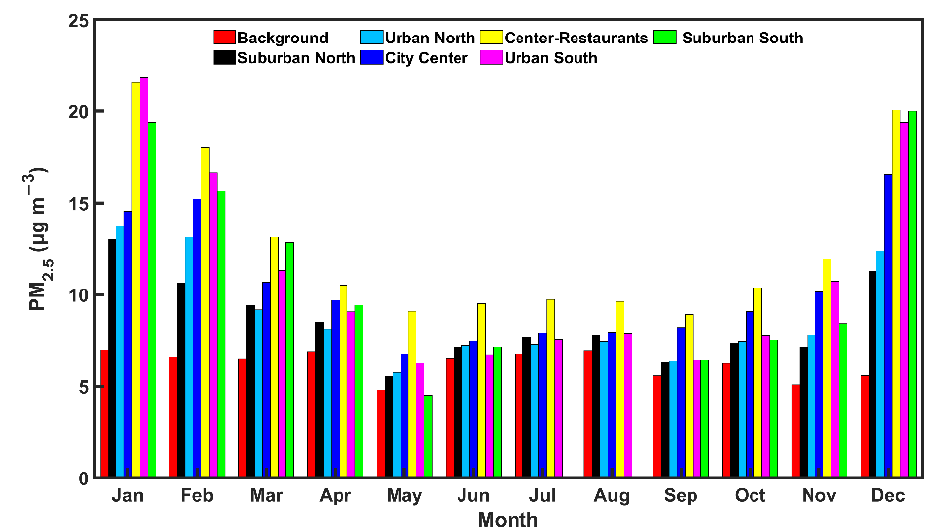
Figure 4. Monthly averaged PM 2.5 concentrations for different areas in the city during 2/2017– 12/2019: (a) background (red); (b) suburban north (black); (c) urban north (cyan); (d) city center (blue); (e) city center restaurants (yellow); (f) urban south (magenta); (g) suburban south (green).